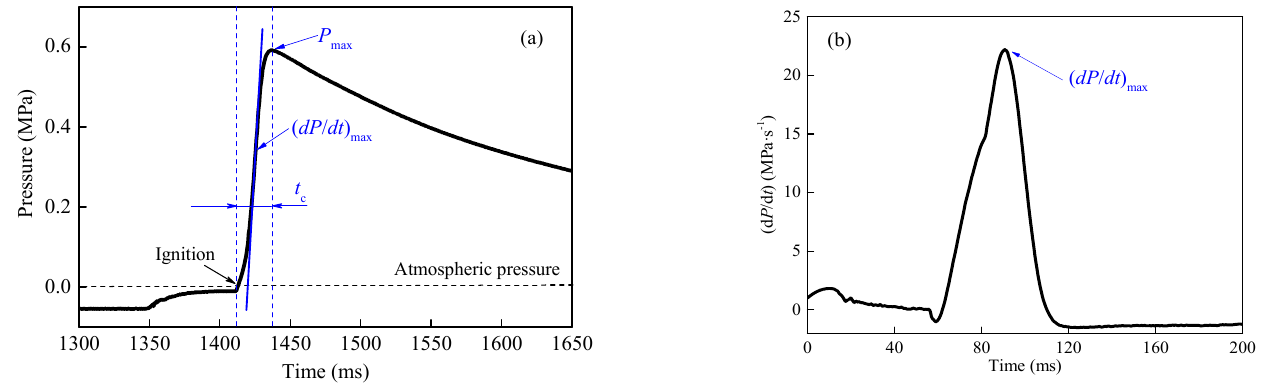
Figure 3. The explosion pressure ( a ) and the first-order derivative of the explosion pressure ( b ).